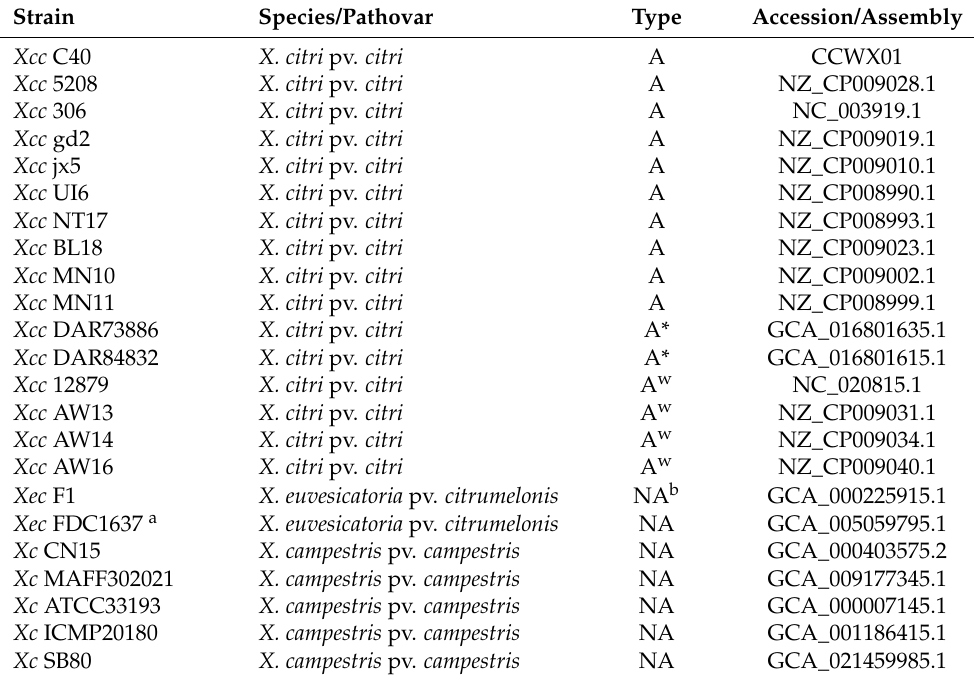
Table 2. Genomes used for in silico MCP